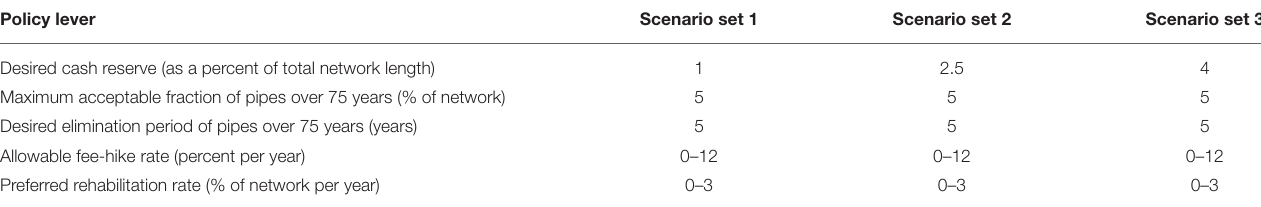
TABLE 5 | Policy levers for three scenario sets. Policy